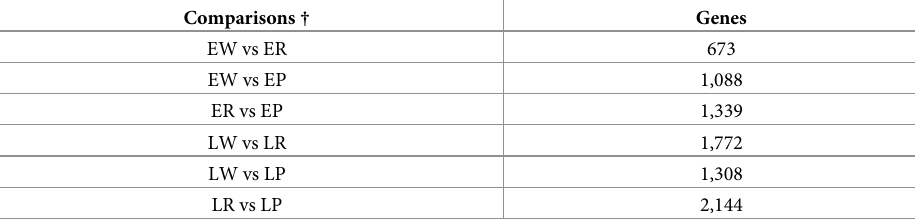
Table 1. Number of genes differentially expressed between stages and spathe